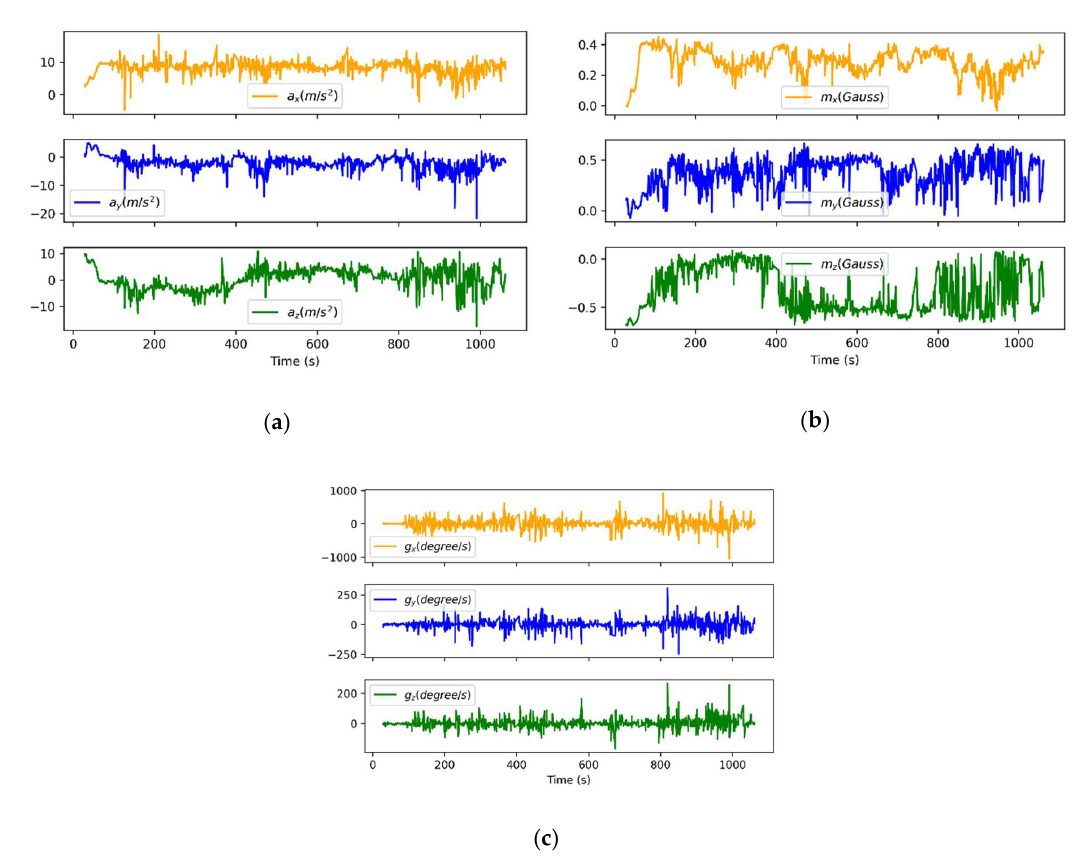
Figure 12. Radioprobe sensor measurements sent to the ground station for postprocessing purposes: ( a ) raw acceleration measured by the radioprobe sensors during the flight; ( b ) raw magnetic field measured by the radioprobe sensors during the flight; and ( c ) raw angular rate measured by the radioprobe sensors during the flight.